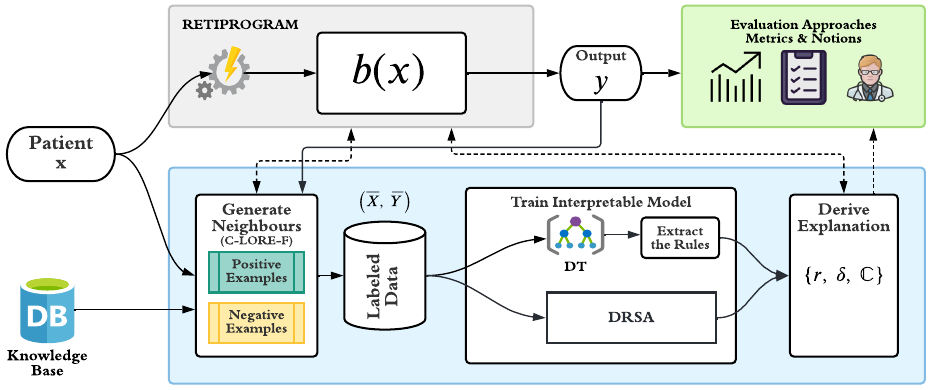
Figure 2. Architecture of the proposed explanation generation